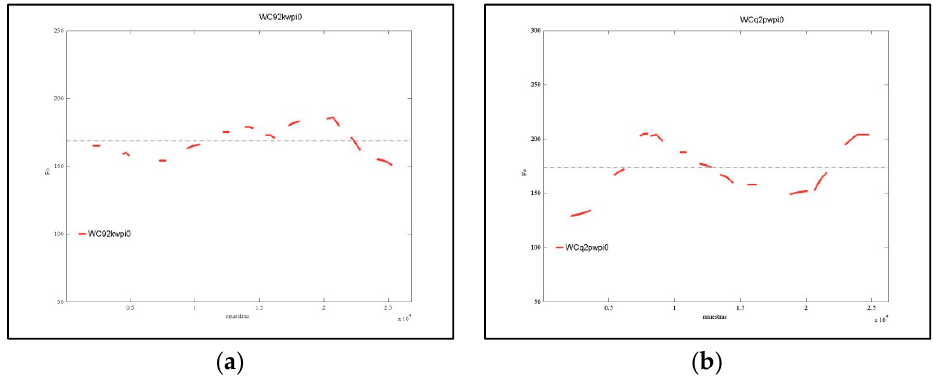
Figure 8. ( a ) Average from El saxofón se toca con pánico (‘The saxophone is played in panic ’ ), uttered as an interrogative sentence by a man from Tenerife; ( b ) La cítara se toca con pánico (‘La zither is played in panic’), uttered as an interrogative sentence by a man from El Hierro.